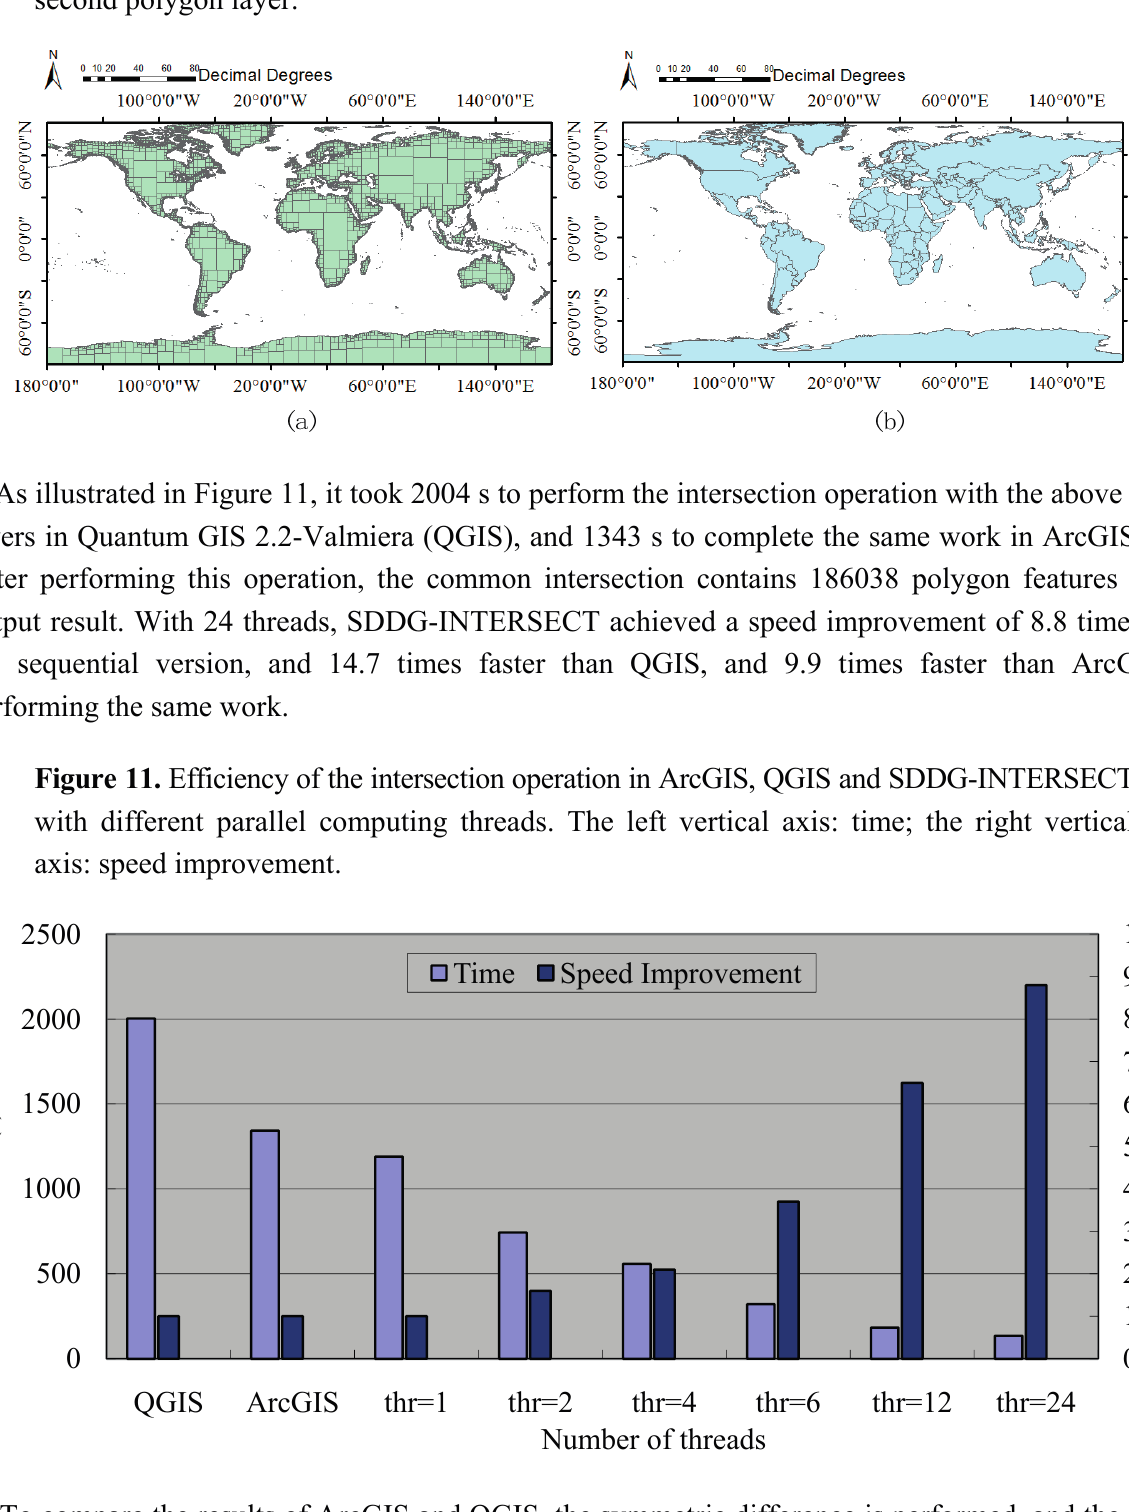
Figure 10. Data sets for the intersection operation. ( a ) The first polygon layer; ( b ) The second polygon layer.